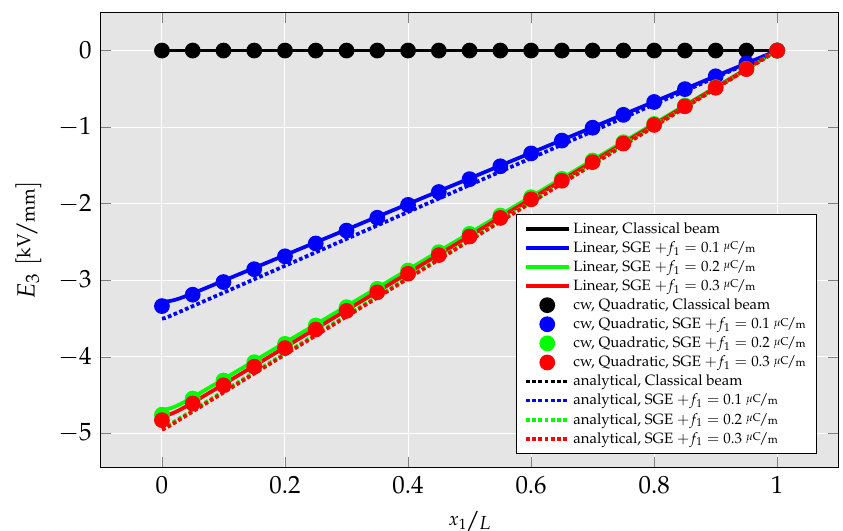
Figure 10. Electric field E 3 generated in the cantilever beam for linear and quadratic element with neglected strain gradient components vs. analytical solution. cw denotes the current